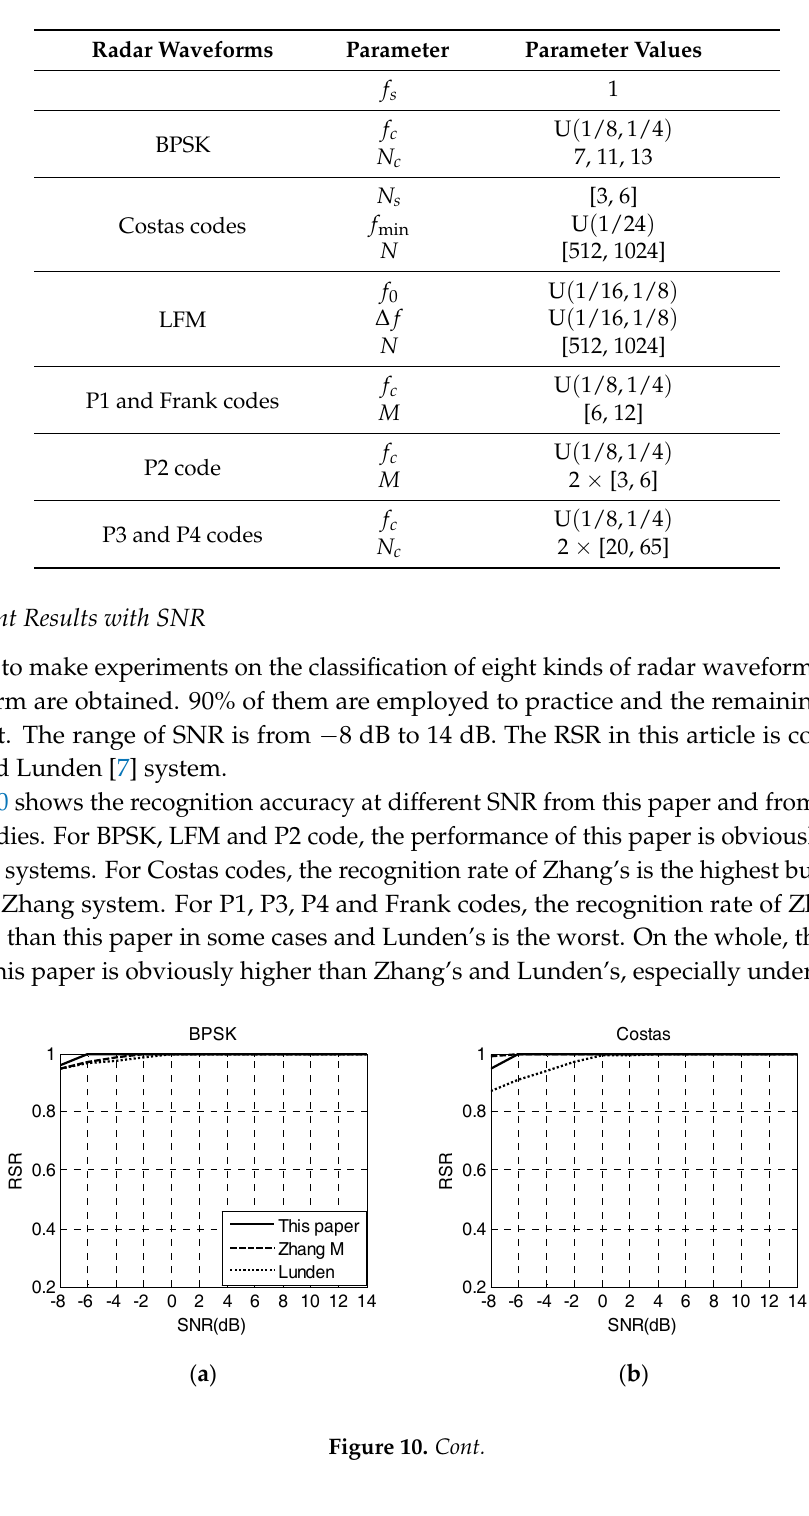
Table 4. Parameters of each